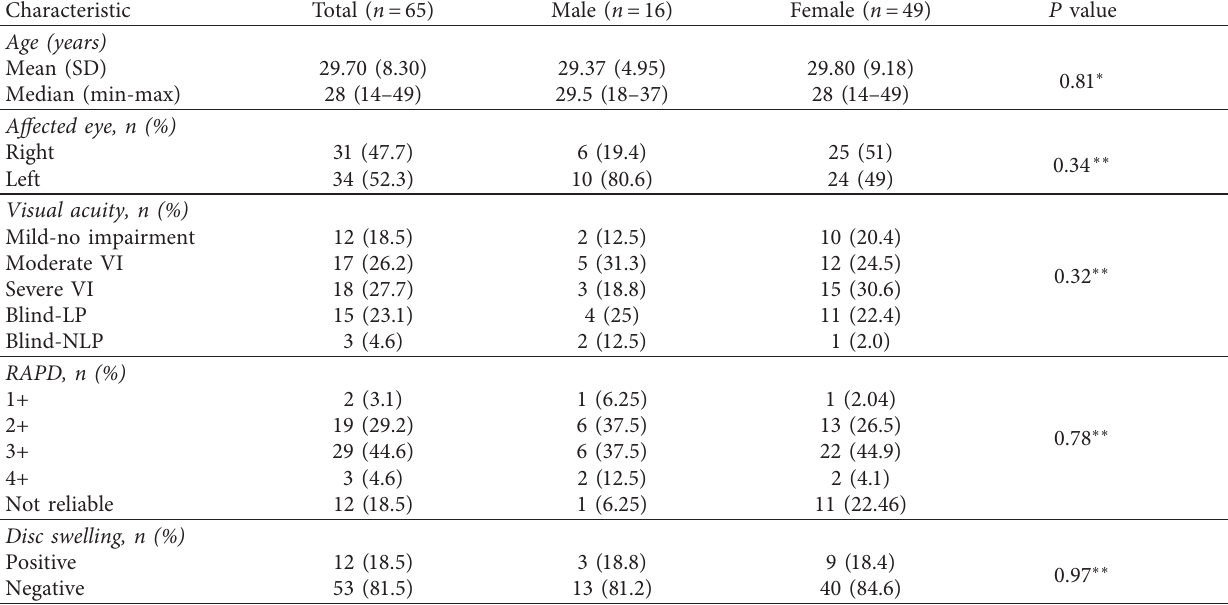
Table 1: Demographics and clinical findings in the idiopathic acute ON group.